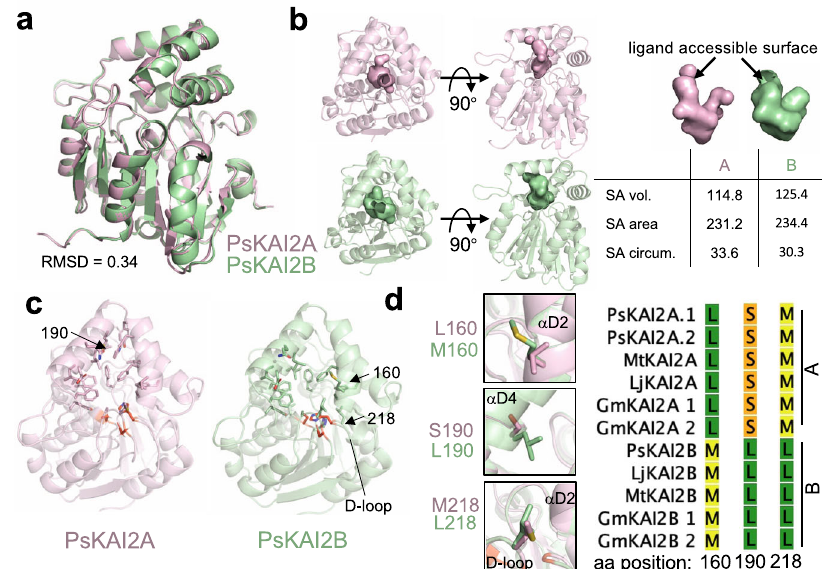
Fig. 7 Structural divergence analysis of legume KAI2A and KAI2B. a Structural alignment of PsKAI2A and PsKAI2B shown in pink and light green colors respectively. RMSD of aligned structures is shown. b Analysis of PsKAI2A and PsKAI2B pocket volume, area, and morphology is shown by solvent accessible surface presentation. Pocket size values were calculated via the CASTp server. c Residues involved in de fi ning ligand-binding pocket are shown on each structure as sticks. Catalytic triad is shown in red. d Residues L/M160, S/L190, and M/L218 are highlighted as divergent legume KAI2 residues, conserved among all legume KAI2A or KAI2B sequences as shown in reduced Multiple Sequence Alignment from Supplementary Fig.